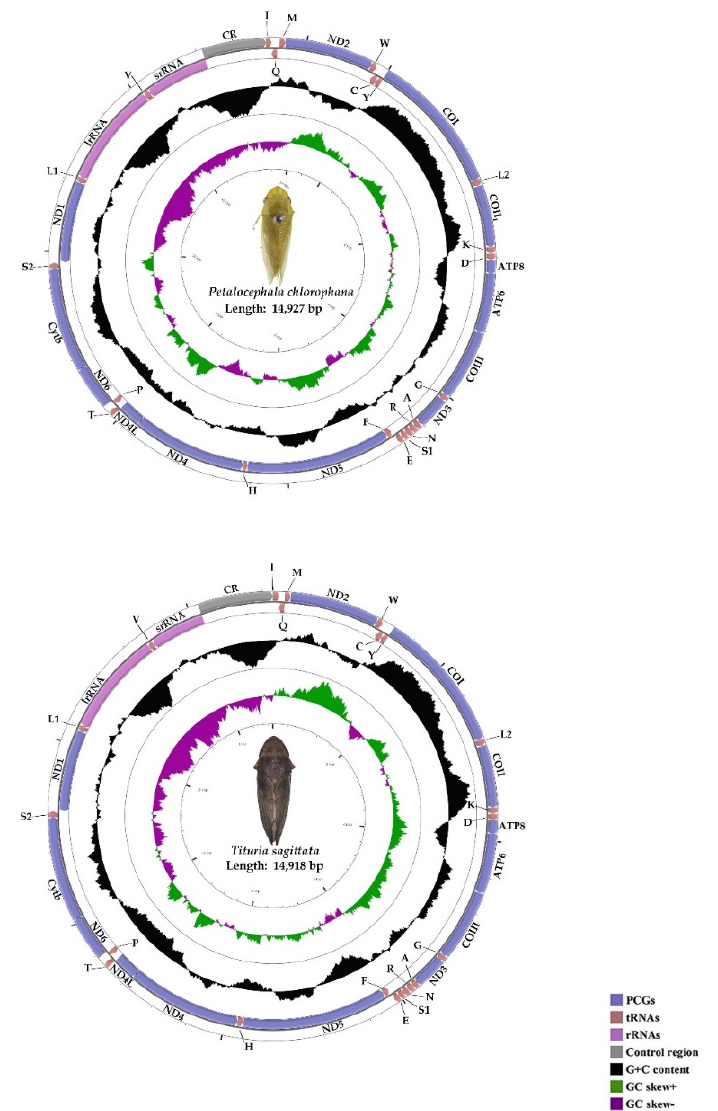
Figure 1. Circular maps of the mtgenomes of Petalocephala chlorophana and Tituria sagittata . The overall base composition of P. chlorophana was A (29.5%), T (47%), C (9.8%), and G (13.5%) and A (29.8%), T (46.7%), C (10.5%), and G (13%) in T. sagittata . Similar to other cicadellid mitogenomes, both mtgenomes were consistently AT nucleotide biased, with 76.6% in P. chlorophana and 76.5% in T. sagittata (Tables 3 and 4). The AT nucleotide content of the 13 PCG genes was the lowest (75.3%, 75.5%), while the AT nucleotide content of the A + T-rich region was the highest (85.4%, 82.3%) (Tables 3 and 4). The composition skew analysis shows a negative AT-skew and a positive GC-skew in the whole mitogenomes (Tables 3 and